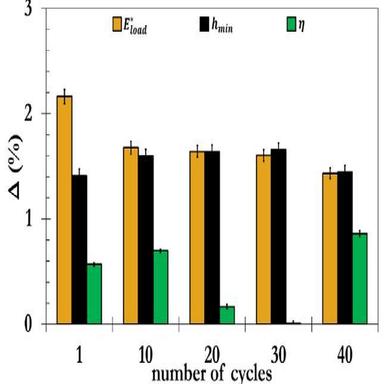
Histogram representing the percent difference between neat polymer and composite core mean values of instantaneous elastic modulus (yellow), residual depth (black) and energy ratio (green) for 1st, 10th, 20th, 30th and 40th cycle.